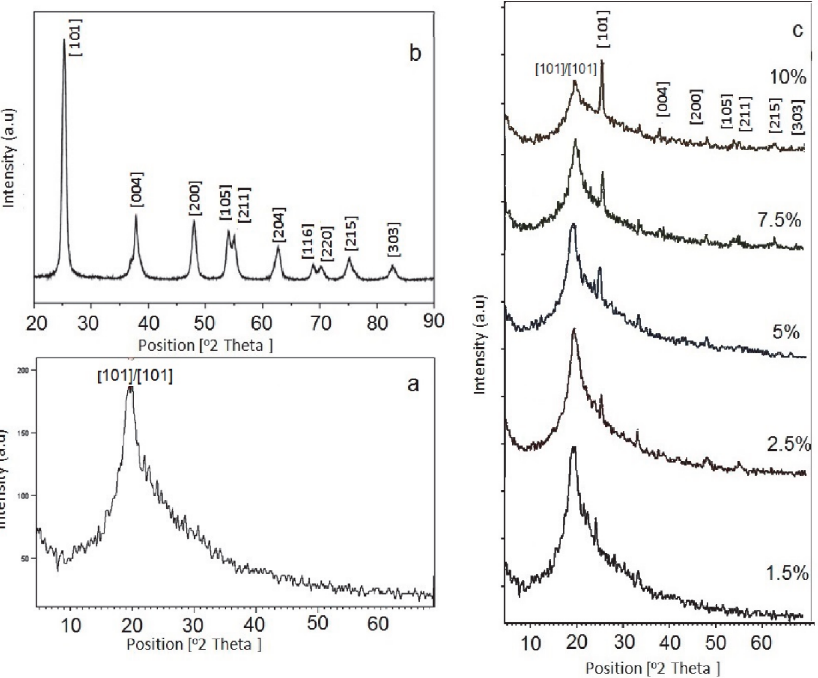
Figure 17. X-ray di ff raction pattern for ( a ) pure PVA, ( b ) pure TiO 2 and ( c ) TiO 2 / PVA composites Figure 17. X-ray diffraction pattern for ( a ) pure PVA, ( b ) pure TiO 2 and ( c ) TiO 2 /PVA composites [154].